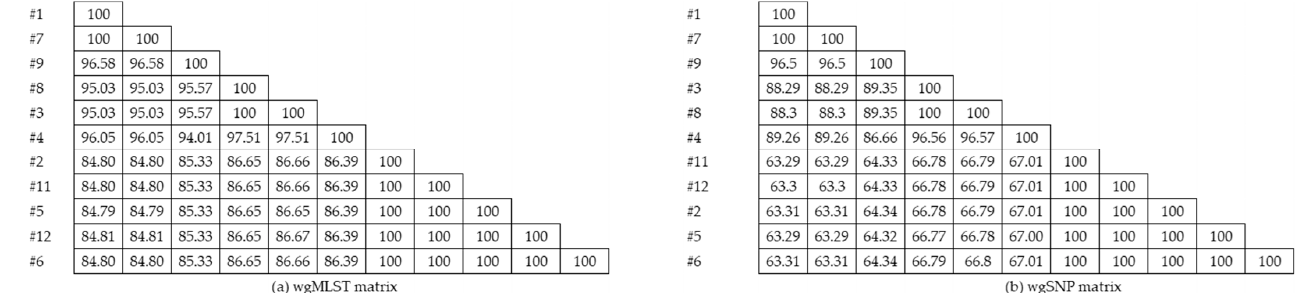
Figure 2. ( a ) wgMLST and ( b ) wgSNP similarity matrix of